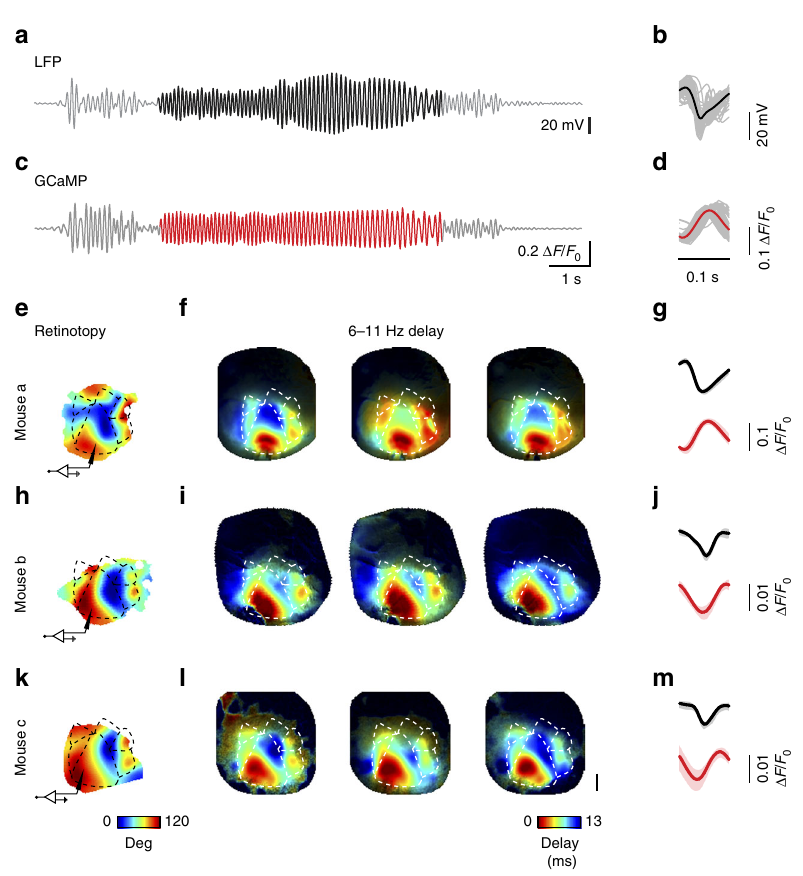
Fig. 6 Homotopic propagation of 6 – 11 Hz oscillations during seizures. a LFP recording of the seizure in Fig. 5a, bandpass fi ltered between 6 and 11 Hz. Highlighted in black is an epoch of coherent oscillations driven by the focus, used for the analysis in the next panels. b Cycle average of the 6 – 11 Hz oscillation from the un fi ltered LFP trace. Gray traces show the individual cycles of the oscillation. c , d Same as a , b , for the GCaMP fl uorescence measured at the focus. Oscillation highlighted in red. e Retinotopic maps for an example animal. The cartoon electrode indicates the site of Ptx injection and LFP recording, the dashed line represents visual areas contours. f Oscillatory delay for three example seizures from this example animal. Delay was obtained from the 6 – 11 Hz Hilbert phase referenced at the focus, averaged across all cycles of the oscillation for a given seizure. g Average LFP cycle ( top ) and average GCaMP fl uorescence ( bottom ), averaged across all the seizures for this animal. Shaded area represents the standard deviation. h – m Same as e – g for six other seizures in two other mice. In all seizures and all mice, the delay of the oscillation faithfully recapitulates the retinotopic maps. Scale bar: 1